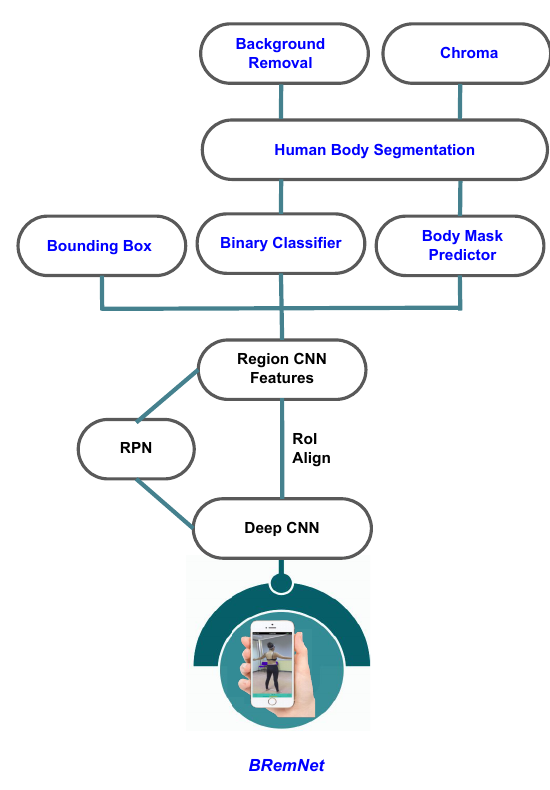
Figure 3. BRemNet